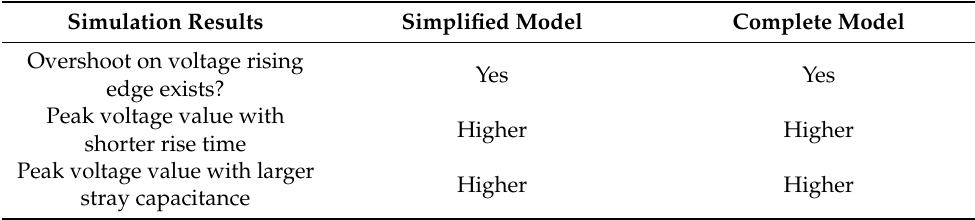
Figure 15. Interturn overvoltage ratio between adjacent turns under different relative permittivity (tr = 200 ns, C-type). Table 6. Similarities between simulation results in simplified model and complete